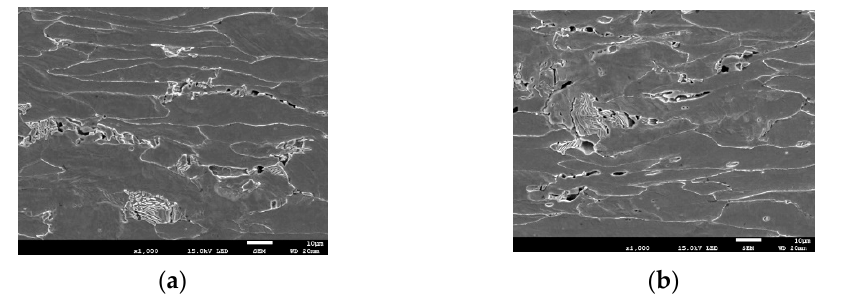
Figure 15. Development of voids in a uniaxially tensile specimen: ( a ) ~1.0 mm since the fracture plane; ( b ) directly at the fracture plane.